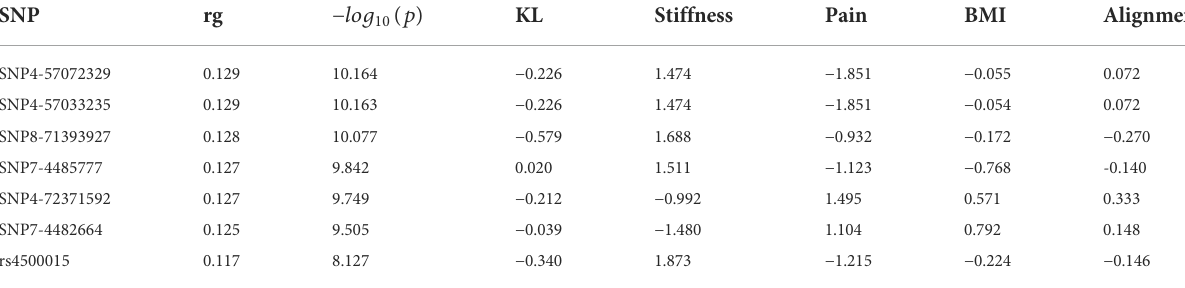
TABLE 1 The lead SNPs at independent loci reaching p ≤ 10 − 8 at multi-trails. SNP rg − log 10 ( p )